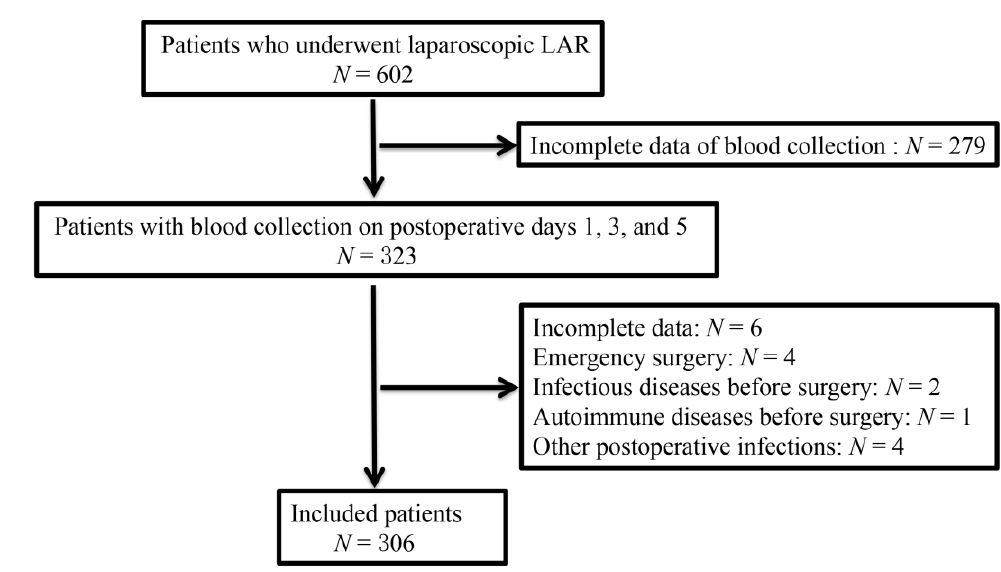
Figure 1. The flow diagram of study protocol. Table 1. Patients clinicopathological data before propensity score-matched